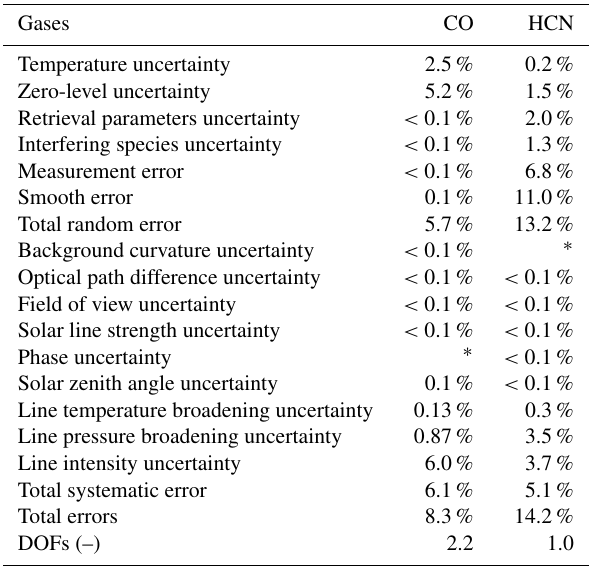
Table 2. Retrieval error budgets and DOFs for tropospheric CO and